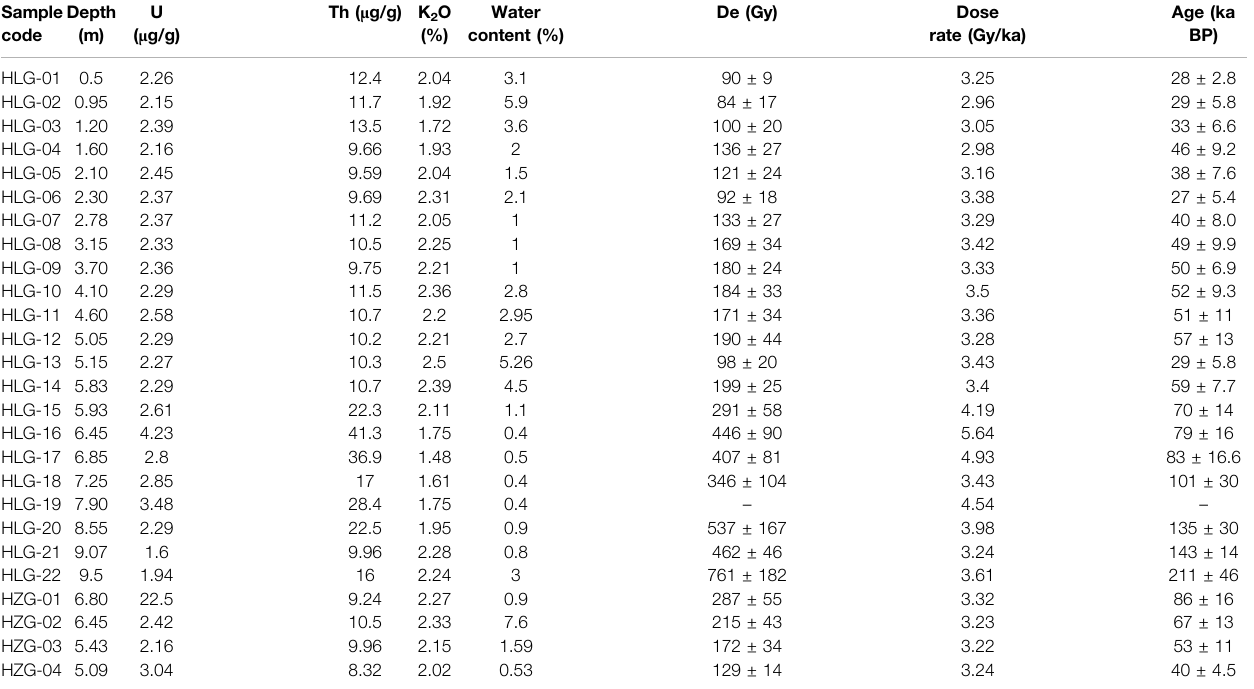
TABLE 3 | Results from the ESR dating of samples collected in Haolaigou pro fi le and Hazigai pro fi le. Sample Depth code